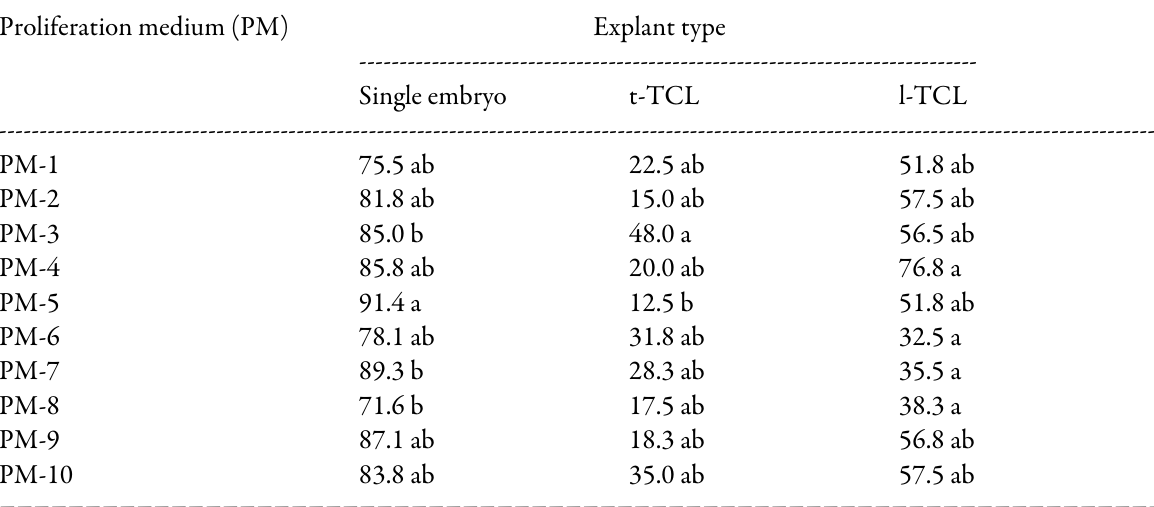
Table 4. Interaction effect of explant types and proliferation media on percentage of explant regeneration (%).